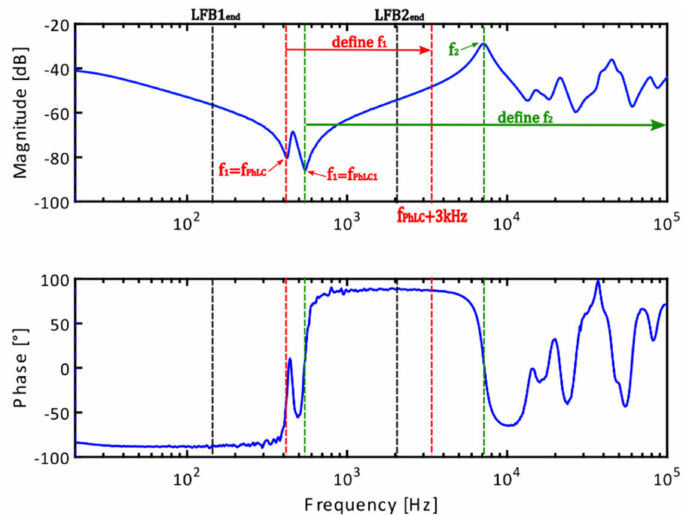
Figure 7. An example of class 1 FRA plot for identification of the LFB1 end and LFB2 end . The algorithm corresponds to class 2 if fPhLC is a minimum peak and there are two maximum peaks below f1. Another scenario for class 2 is that fPhLC is a crest. In this case, the algorithm searches for the next minimum peak in the range f1 and 10 kHz, for which phase crosses zero line from inductive to capacitive. If such a peak is found, f1 becomes the frequency of this point. After finding f1, a maximum peak with phase transition from capacitive to inductive is searched between f1 and 100 kHz as illustrated in Figure 8. If this crest is found, the LFB1 end is determined as a medium frequency between LFB1 start and f1, whereas LFB2 end is determined as a medium frequency between f1 and f2. If f2 is not found, the algorithm checks the number of phase zero-crossings below f1. LFB2 end is fixed at 8 kHz if phase zero-crossings below f1 are greater than or equal to 1; otherwise, LFB2 end becomes 15 kHz.